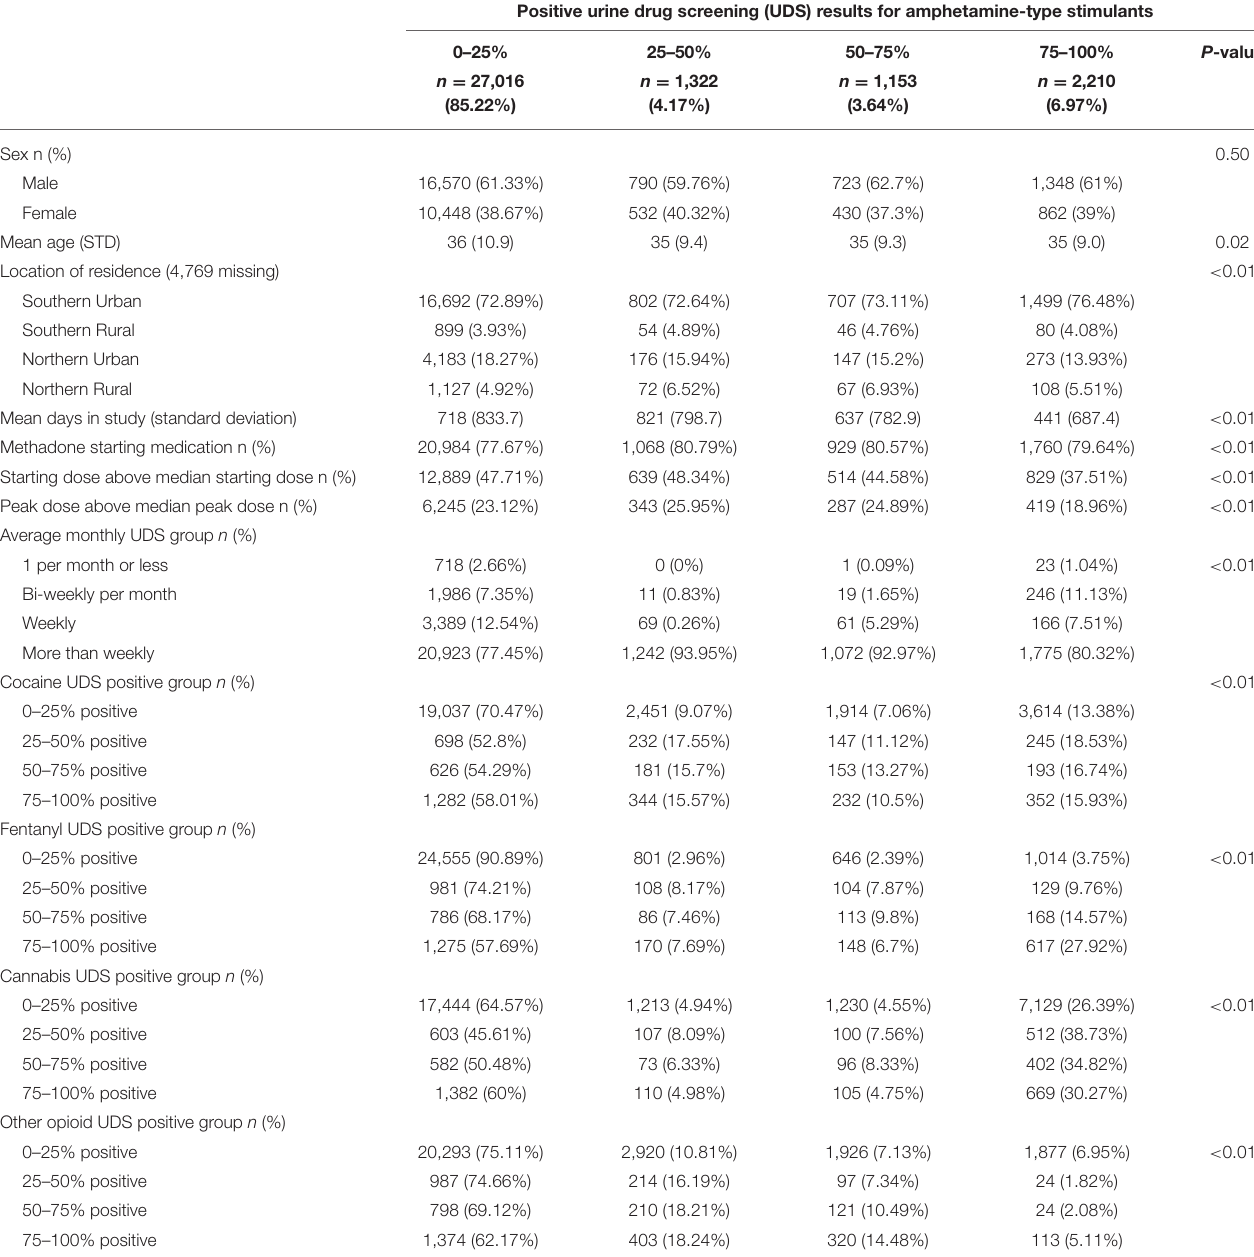
TABLE 1 | Patient characteristics, clinical factors and substance use behaviors, stratified by amphetamine-type use groups among 31,701 people in OAT in Ontario,